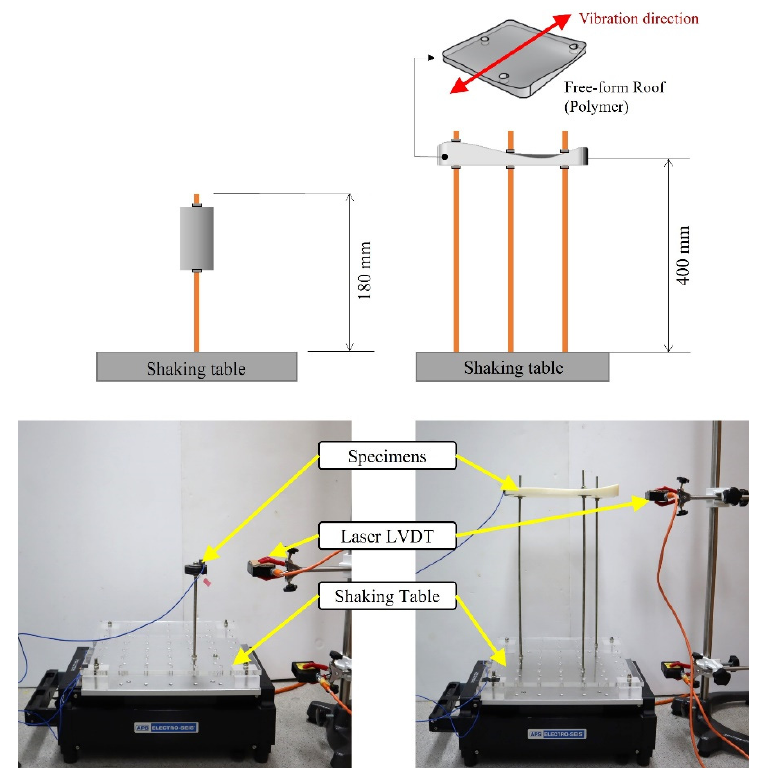
Table 3. Reduction rates of parameters depending on the height ratio ( h ) by similitude law.